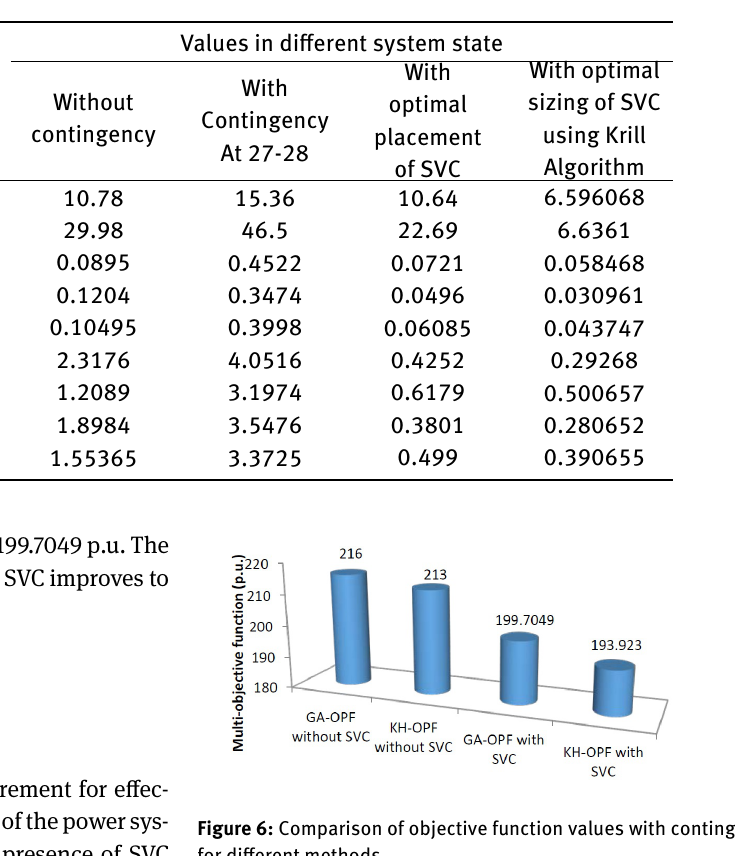
Table 7: Comparison of results without contingency, with contingency at line (27-28)